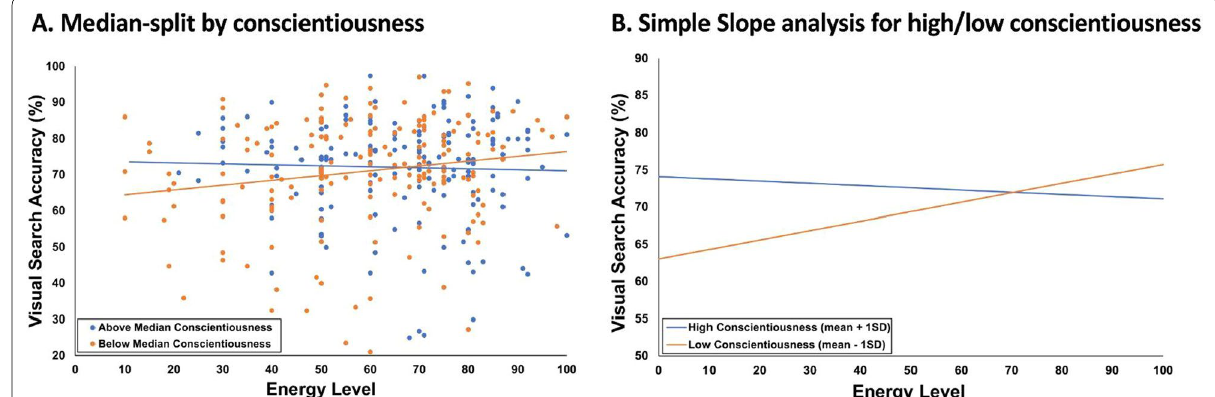
Fig. 3. Non-preregistered analyses to illustrate nature of primary result: A Target-present accuracy by energy, separated for the participants with above-median (blue) and below-median (orange) conscientiousness scores. The vertical axis range begins at 20 given that data exclusion parameters removed visual search data from participants with an average performance below 20%. B Computed simple slope analysis for target-present accuracy by energy for data one standard deviation above (blue) and below (orange) the